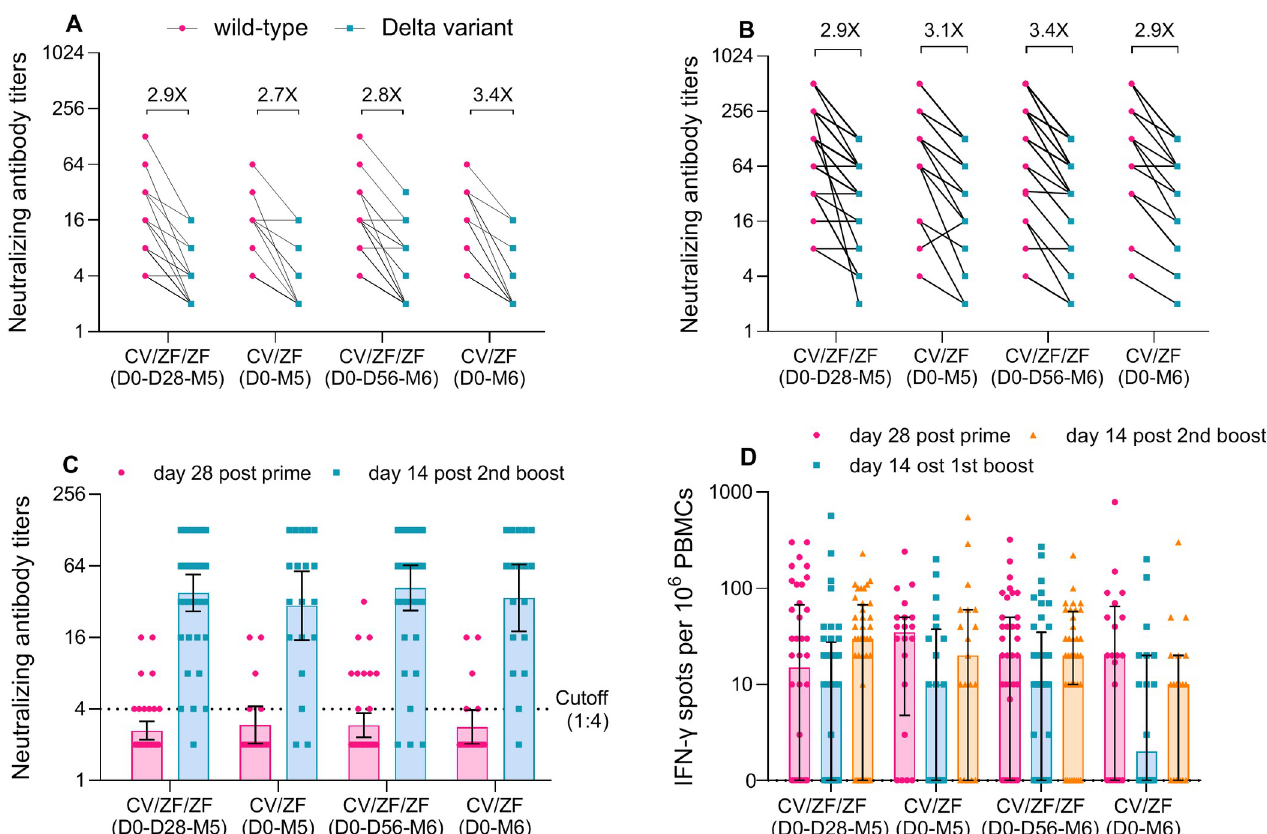
Fig 5. Neutralizing antibodies against the Delta variant and specific T-cell responses after prime and boost dose. (A and B) Geometric mean ratios of neutralizing antibodies against wild-type relative to Delta 28 days post prime dose ( A ), and 14 days post second boost dose ( B ). ( C ) GMTs of neutralizing antibodies to the Delta variant 28 days post prime dose and 14 days post second boost dose. ( D ) Spot-forming cells with secretion of IFN- γ cytokines per 1 × 10 6 PBMCs measured by ELISpot 28 days post prime dose, and 14 days post first and second boost dose. The numbers indicate the geometric mean ratios. Cutoff (1:4) refers to the detection limit. Horizontal bars show geometric mean titer (C) and median (D). Error bars show 95% CI in panel ( C ), and interquartile range in panel ( D ). CV/ZF/ZF (D0-D28-M5) = receiving Convidecia/ZF2001/ZF2001 at day 0, day 28, and month 5; CV/ZF (D0-M5) = receiving Convidecia/ZF2001 at day 0 and month 5; CV/ZF/ZF (D0-D56-M6) = receiving Convidecia/ZF2001/ZF2001 at day 0, day 56, and month 6; CV/ZF (D0-M6) = receiving Convidecia/ZF2001 at day 0 and month 6. CI, confidence interval; ELISpot, enzyme-linked immunospot; GMT, geometric mean titer; IFN, interferon; PBMC, peripheral blood mononuclear